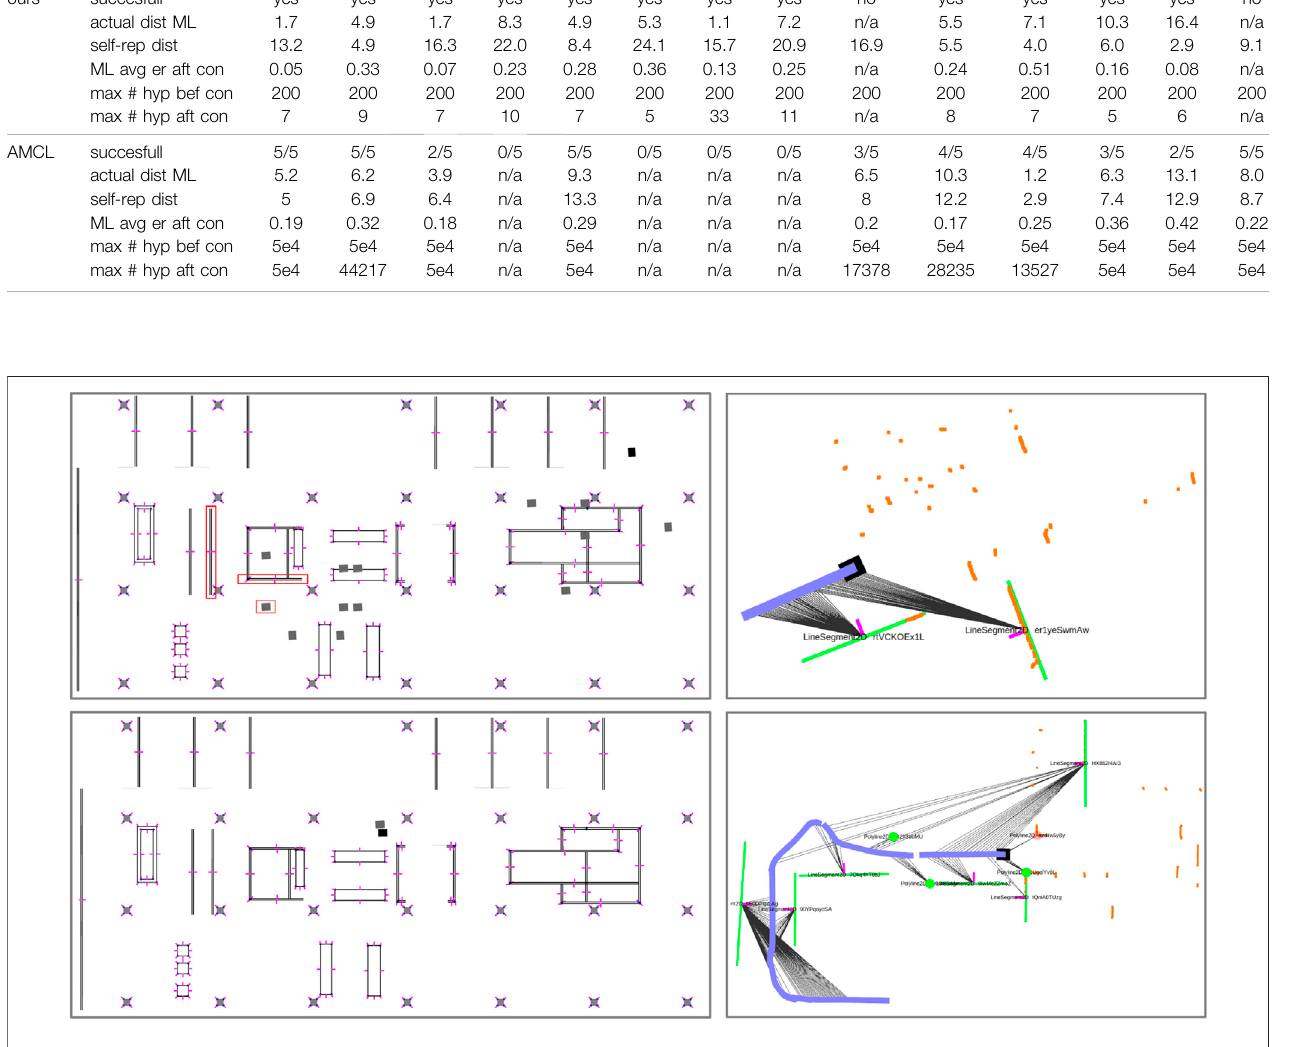
Frontiers in Robotics and AI |